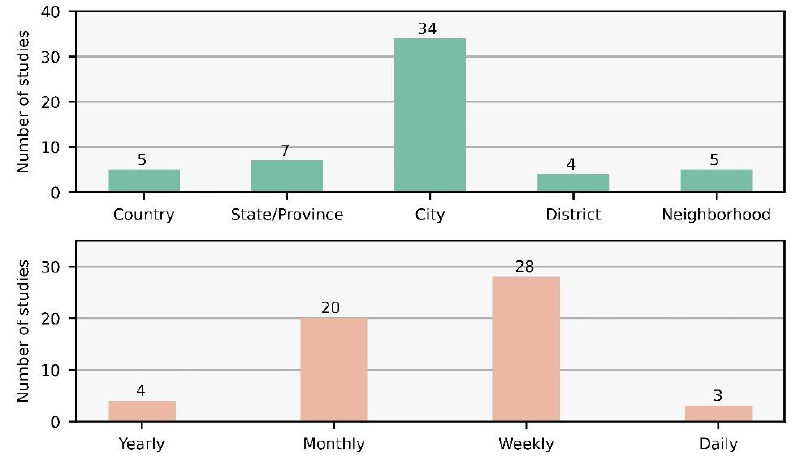
Figure 5. Spatial and temporal scales used in recent studies of dengue risk forecasting.